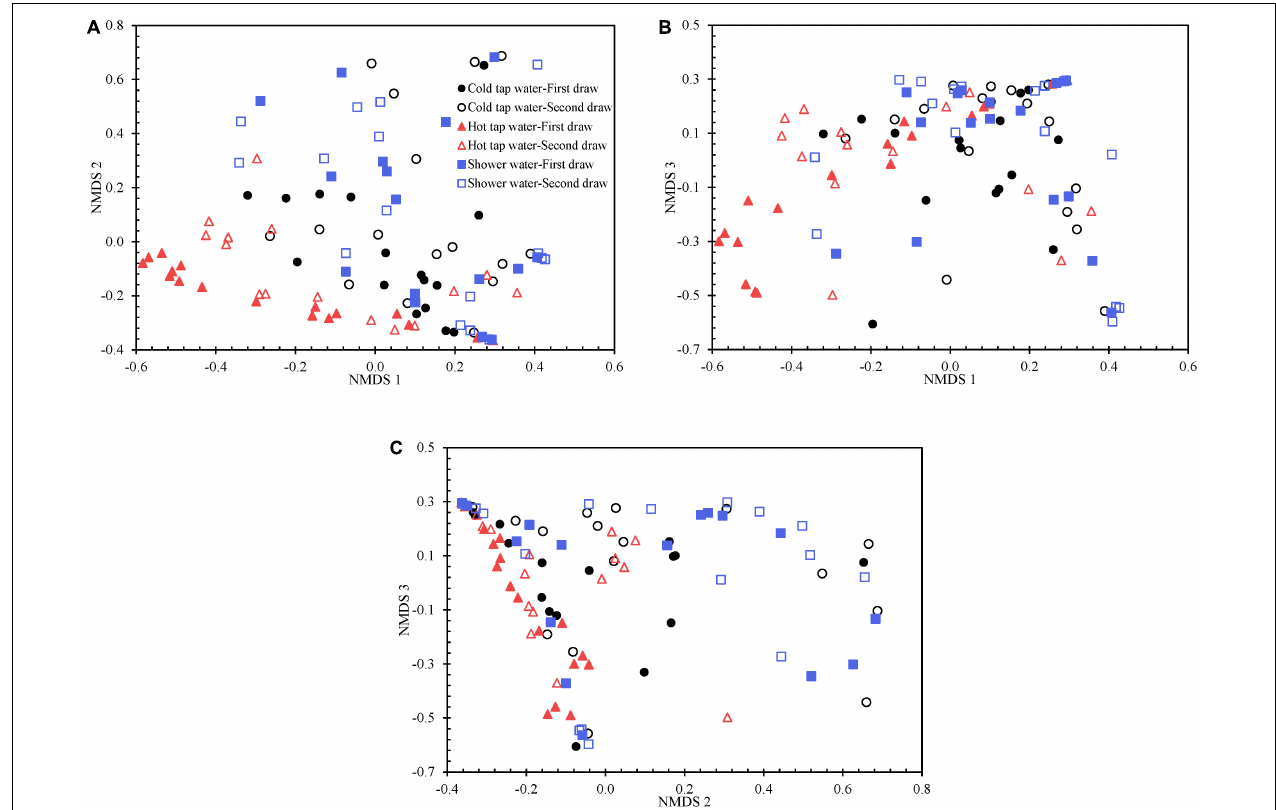
FIGURE 5 | The 3D NMDS of the Yue and Clayton theta distance matrix for all water samples visualized using three two-dimensional plots. (A) NMDS 1 versus NMDS 2. (B) NMDS 1 versus NMDS 3. (C) NMDS 2 versus NMDS 3.